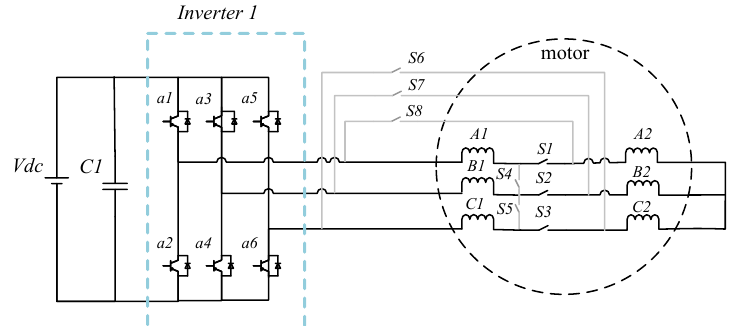
Figure 3. Low-speed operation of RW.